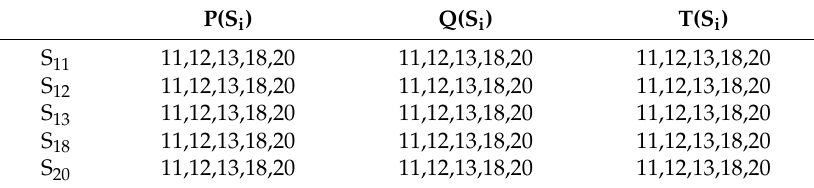
Table 12. Seventh level of reachability set, leading set, and their